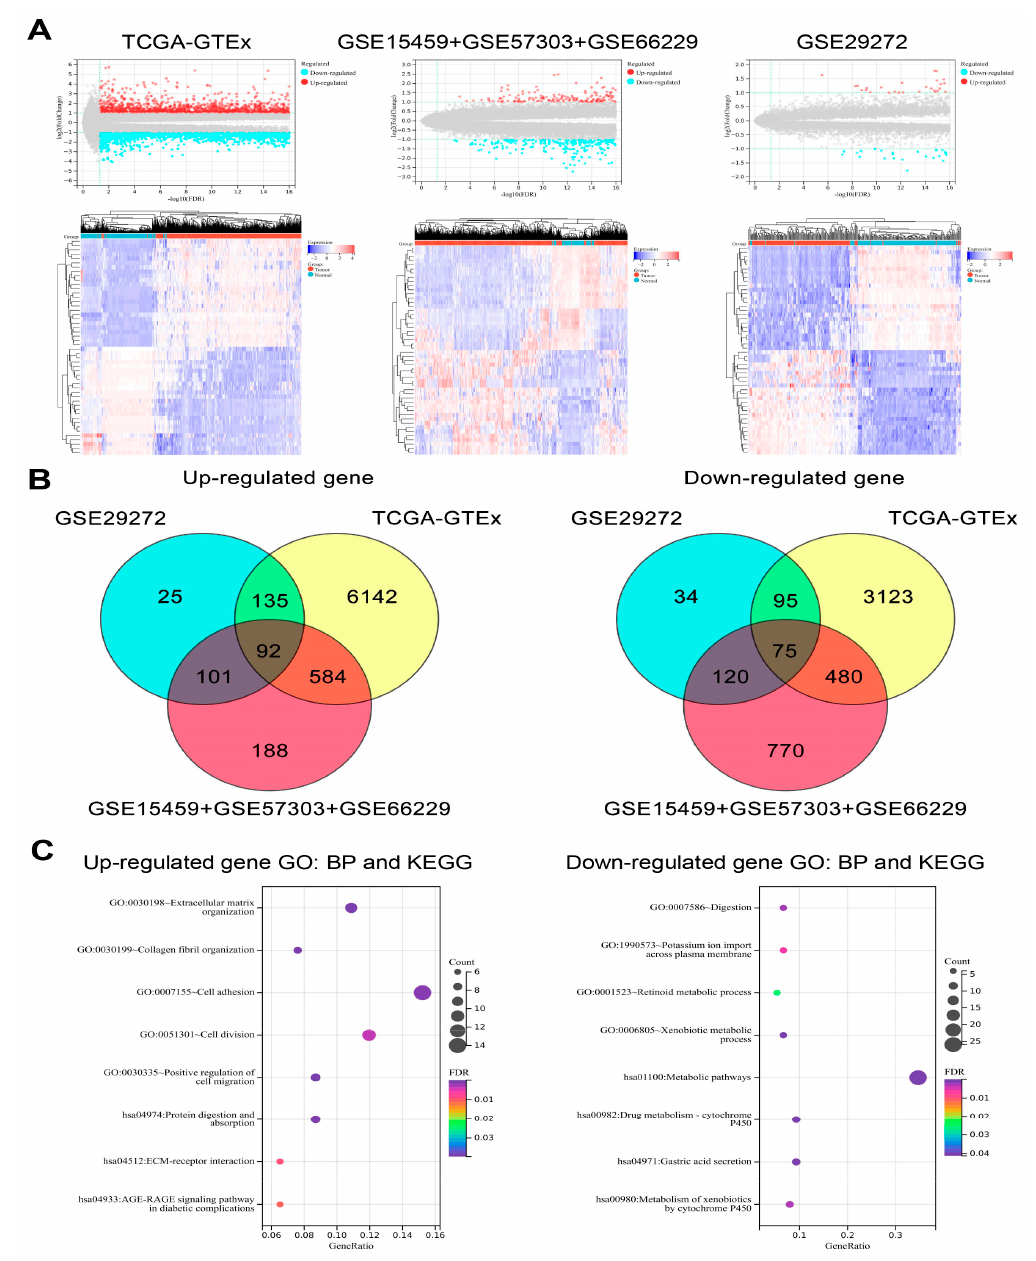
Figure 11. The analysis of the bulk RNA-seq datasets. ( A ) Volcano plots and heatmaps show the DEGs between the tumor and normal tissues in bulk RNA-seq datasets. ( B ) Venn plots showing the common up-regulated and down-regulated genes in different bulk RNA-seq datasets. ( C ) Bubble plots show the functional enrichment results of the up-regulated and down-regulated